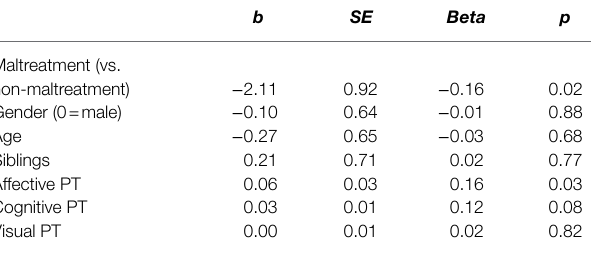
TABLE 4 | Linear Regression Model I: prosocial behaviors.